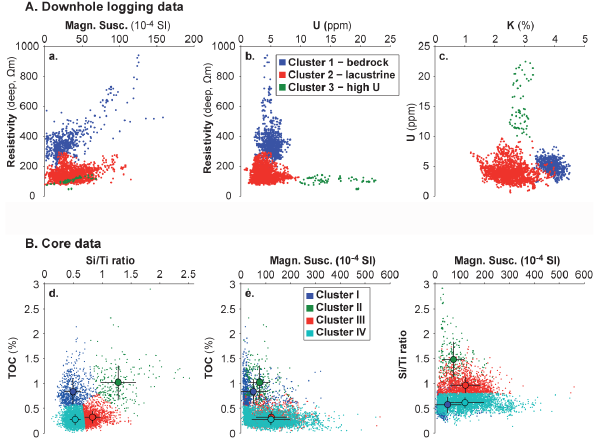
Fig. 4. Crossplots of clusters vs. geophysical and geochemical pa- rameters. Upper panel: clusters 1 to 3 derived from k-mean cluster- ing of downhole logging data (electrical resistivity (deep and shal- low), magnetic susceptibility, U, Th, and K counts). Lower panel: clusters I to V derived from k-mean clustering of core data (TOC content, Si/Ti ratio, standardized magnetic susceptibility). In the lower panel, mean and standard deviation of parameters are shown for each